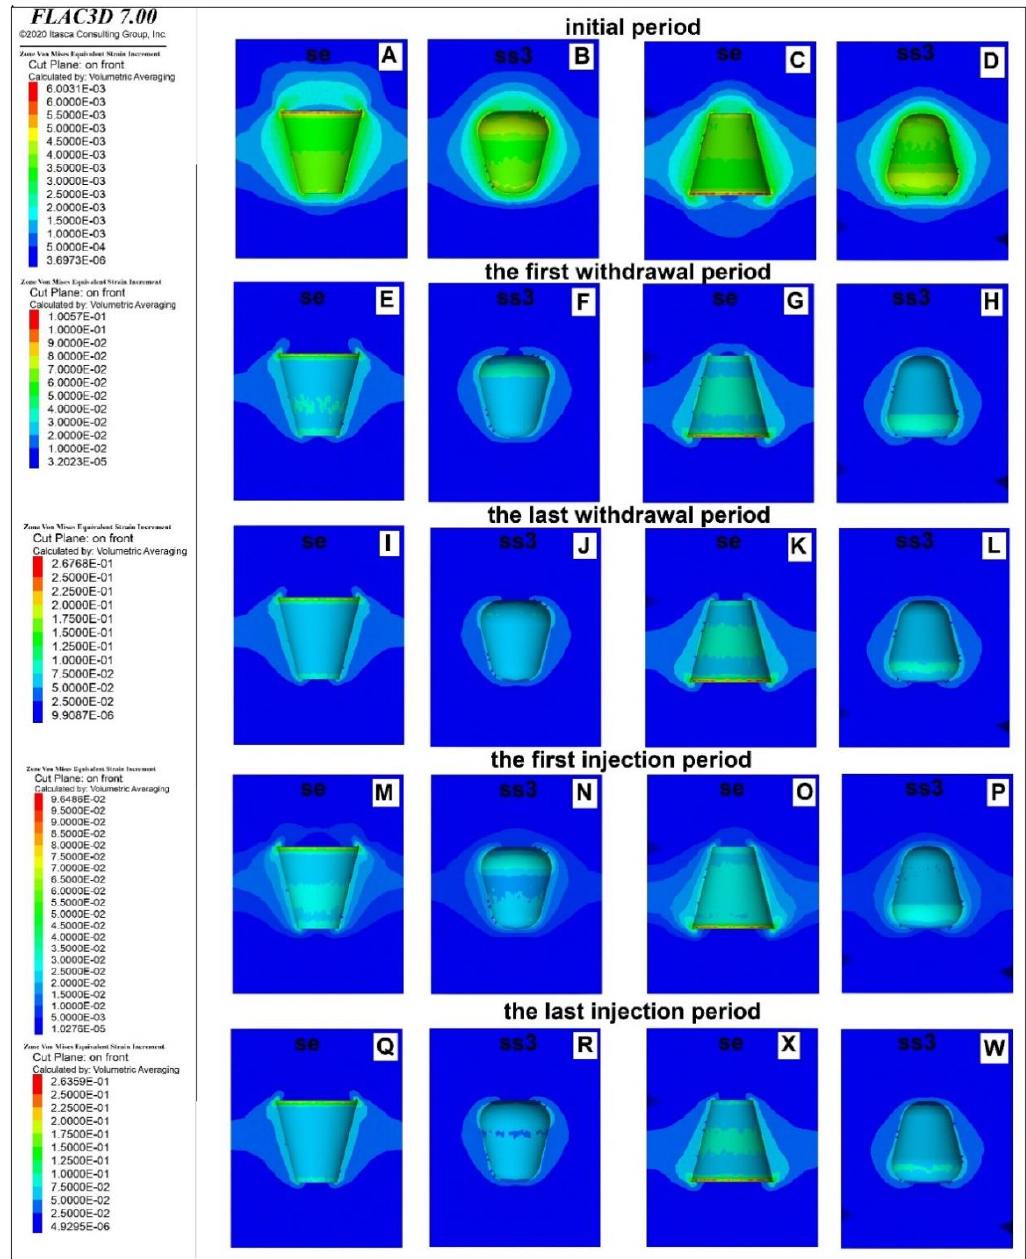
Figure 10. The comparison of effective strain (ES) between enlarged-top and bottom caverns with a maximum initial diameter of 120 m ( A – W ).